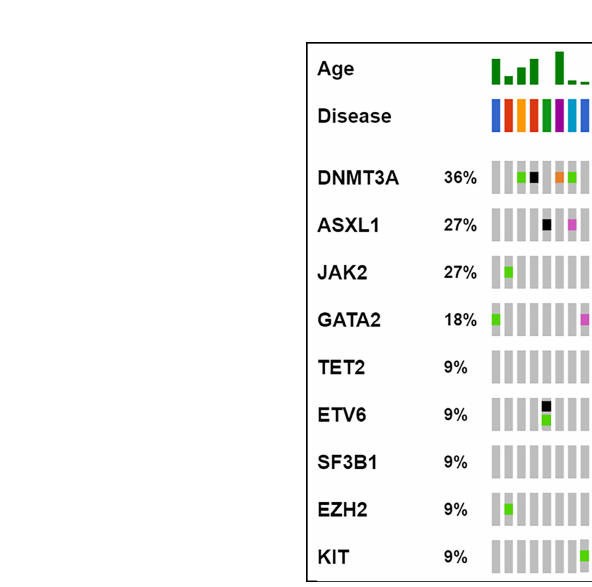
FIGURE 1 | Oncoprinter visualization of all variants identi fi ed. For all cases (columns), the age, the hematological disease and the variants identi fi ed are reported. The percentage value associated to each gene, indicates its variants occurrence in the cohort analyzed. AML, acute myeloid leukemia; CLL, chronic lymphocytic leukemia; CML, chronic myeloid leukemia; DLBCL, diffuse large B-cell lymphoma; MDS, myelodysplastic syndrome; NH, non-Hodgkin ’ s lymphoma; T-NHL, T-cell non-Hodgkin ’ s